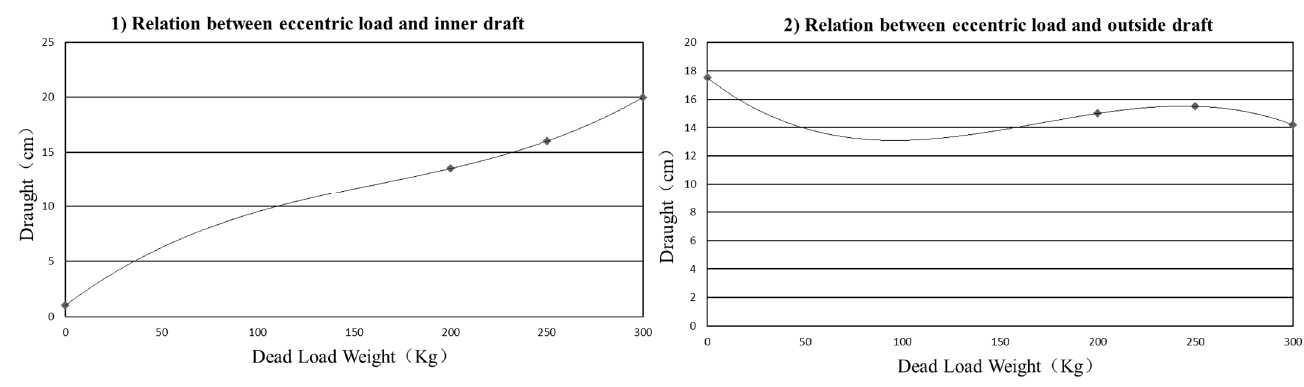
Figure 17. The draft relation curve between eccentric load and position.